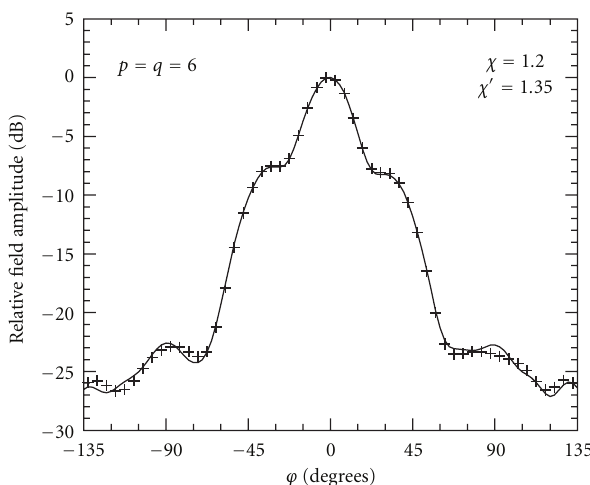
Figure 21: H-plane pattern. Solid line: reference. Crosses: recon- structed from NF data acquired via the helicoidal scanning.